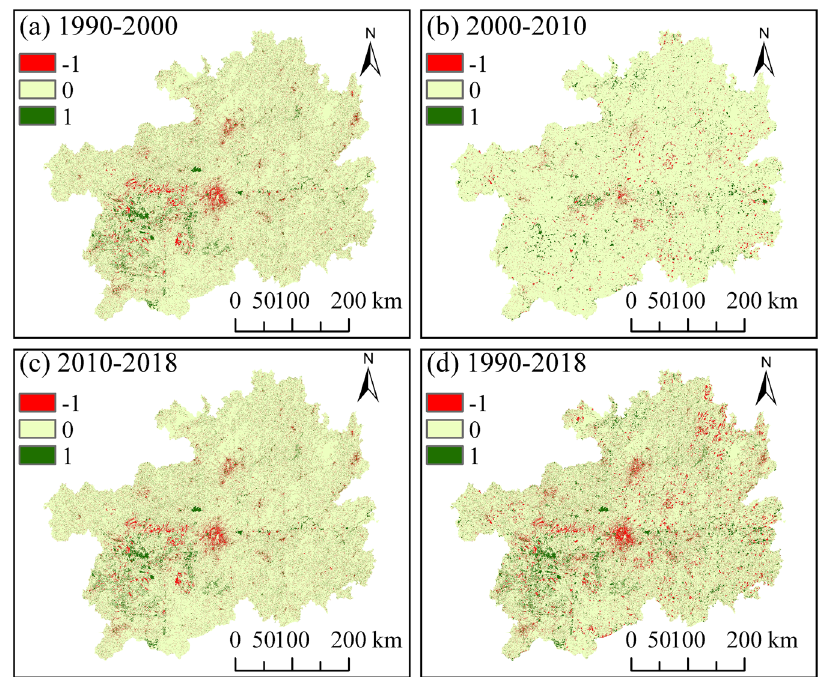
Figure 4. Variations in the spatial patterns of HQ in Guizhou Province over the 1990–2018